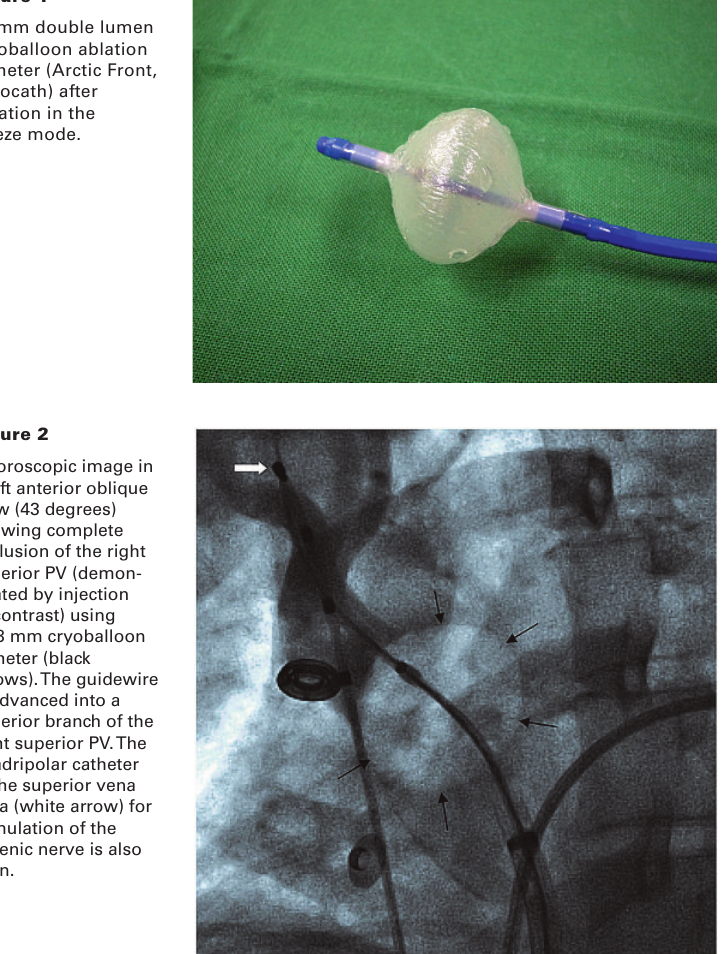
28 mm double lumen cryoballoon ablation catheter (Arctic Front, Cryocath) after inflation in the freeze mode.